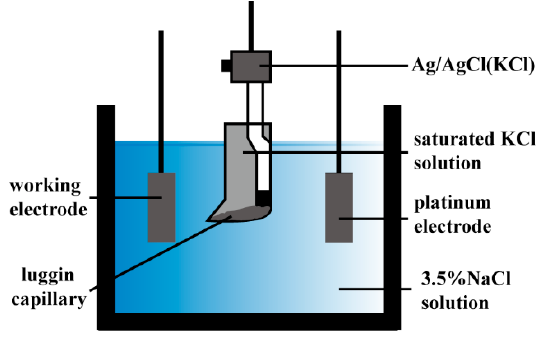
Figure 2. Schematic diagram of three-electrode system.